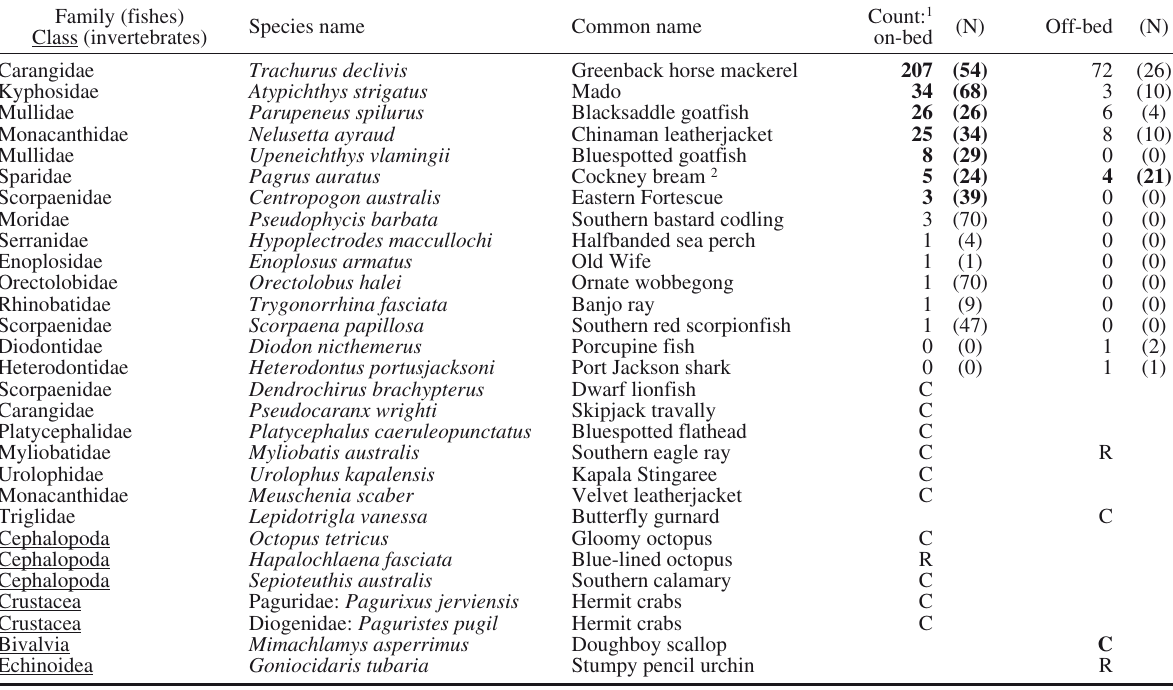
Table 1. – Species common on the shell bed. Counts are the maximum count in a single sampled video frame (N of 70 frames in which spe- cies was present in parenthesis, see Methods). Bold indicates habitats with significantly more individuals on at least one of two video-frame sample periods. None of these species are commonly (C) encountered in nearby off–shell bed habitats except where indicated, although some are occasionally recorded (R). Family (fishes) Class